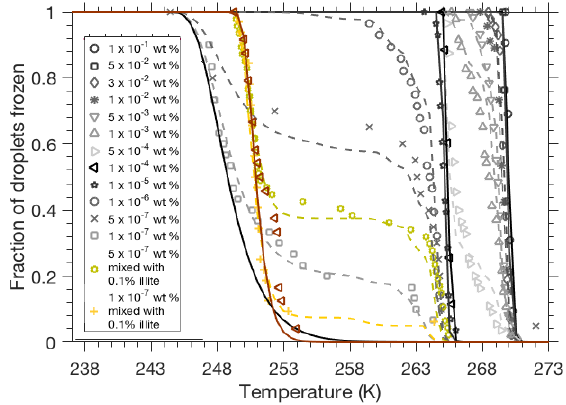
Figure 5. All droplet freezing spectra for Snomax-containing droplets from Fig. 1 shown in grey, along with the frozen fraction curves corresponding to 0.05wt% illite (dark red), a 1:1 mixture of 5 10 − 7 wt% Snomax and 0.1wt% illite (yellow), and a 1:1 × mixture of 1 10 − 7 wt% Snomax and 0.1wt% illite (orange). The × modeled frozen fraction curve for the 0.05wt% illite frozen frac- tion curve is also plotted (solid dark-red line) along with the fits for the frozen fraction curves corresponding to the Snomax–illite mix- tures (yellow and orange dashed lines). Solid black lines on the right are frozen fraction curves that can be described by a g distribution ( g 1 and g 2 ) . The solid black line on the left is the modeled frozen fraction curve of the background